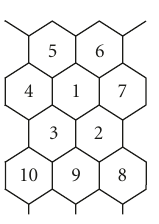
Figure 2: Hexagonal structure of cellular wireless